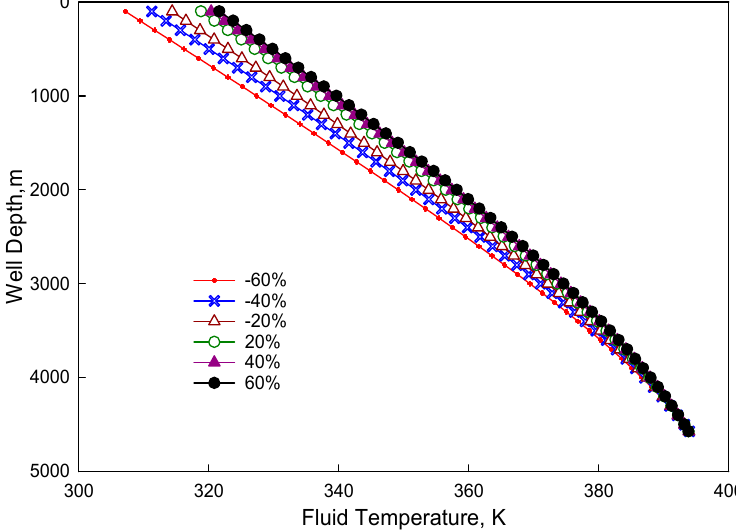
Figure 5. Effect of oil flow rate on the temperature distribution curve in the annulus.